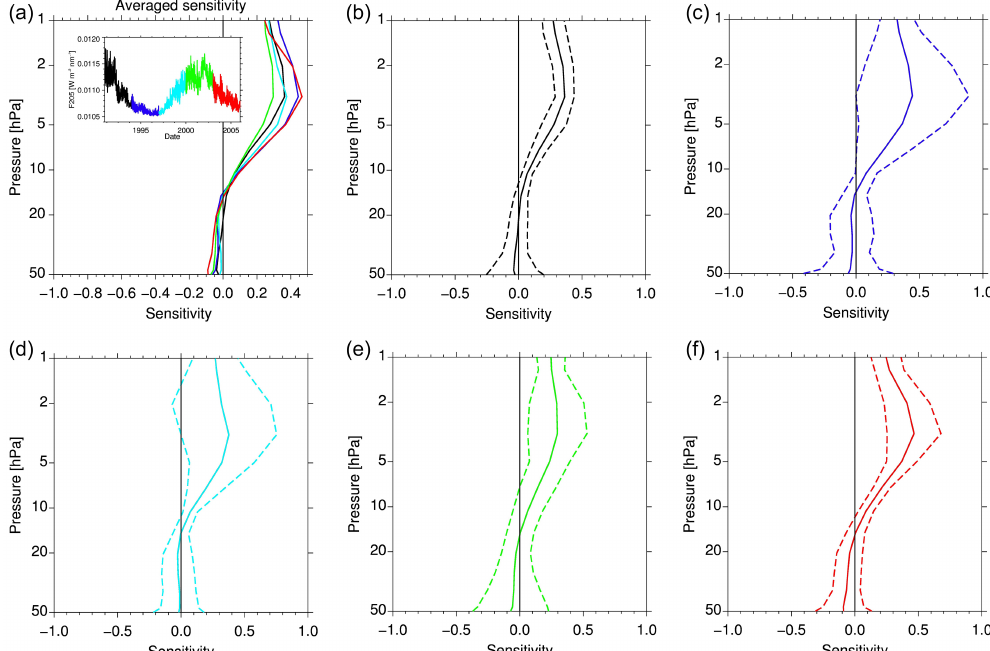
Figure 8. (a) CCM ensemble ozone sensitivity profile at lag 0 for each of the 3-year period. Each period and its corresponding color is shown in the insert plot (a) . CCM ensemble mean ozone sensitivity profile and its 2 σ range are shown for each individual 3-year period: (b) July 1990–June 1993, (c) July 1993–June 1996, (d) July 1996–June 1999, (e) July 1999–June 2002, and (f) July 2002–June